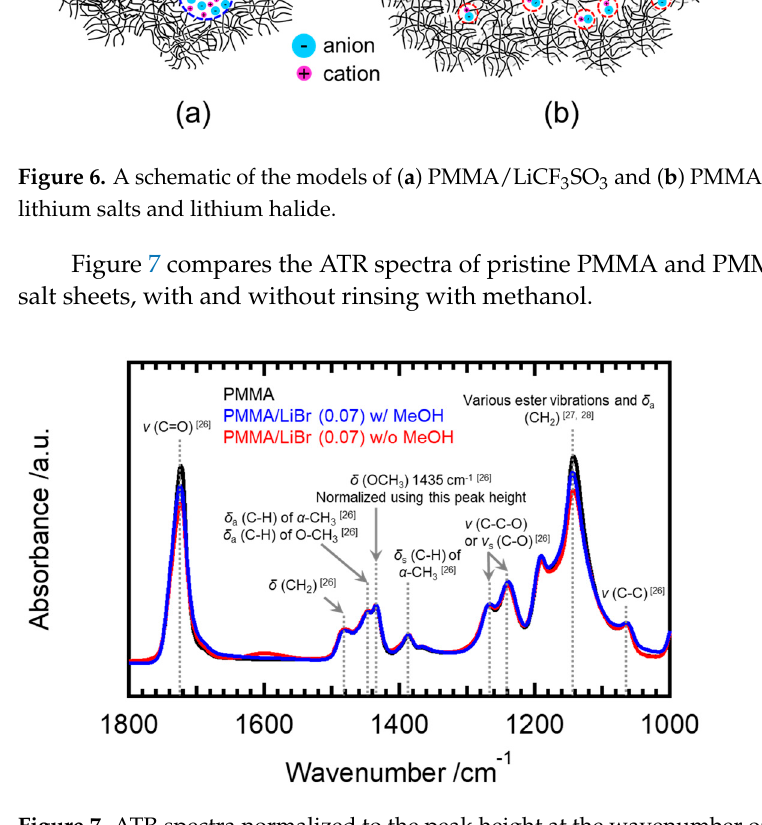
Figure 7. ATR spectra normalized to the peak height at the wavenumber of 1435 cm − 1 , for PMMA (black), PMMA/LiBr after rinsing with methanol (blue), and PMMA/LiBr (red), for wavenumbers in the 1000–1800 cm − 1 range. Their concentrations of LiBr are [Li]/[C=O] = 0.07.